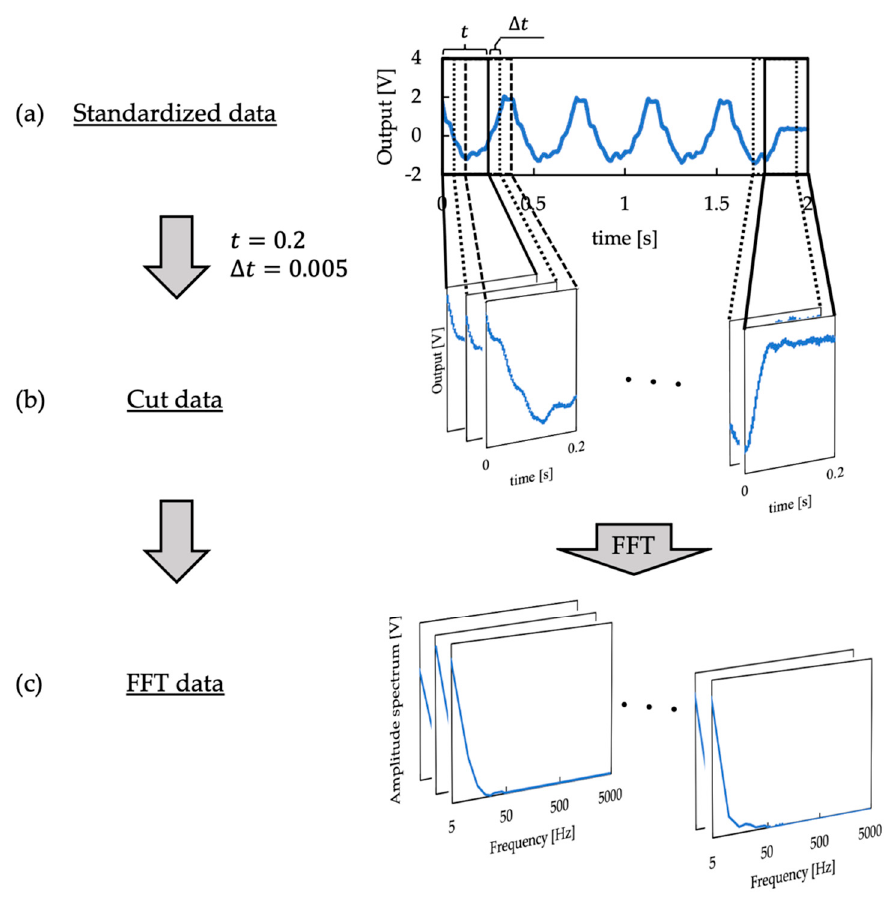
Figure 5. Procedure of generating the input vibration data for deep autoencoders.